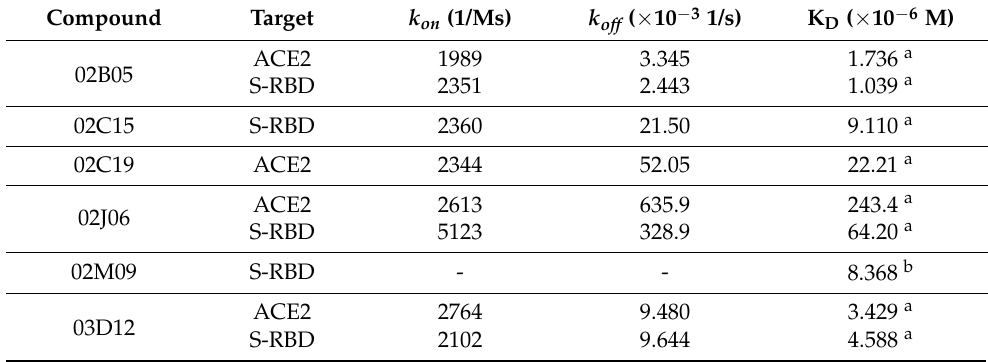
Table 1. Kinetics/affinity evaluation of ACE2 and S-RBD with different